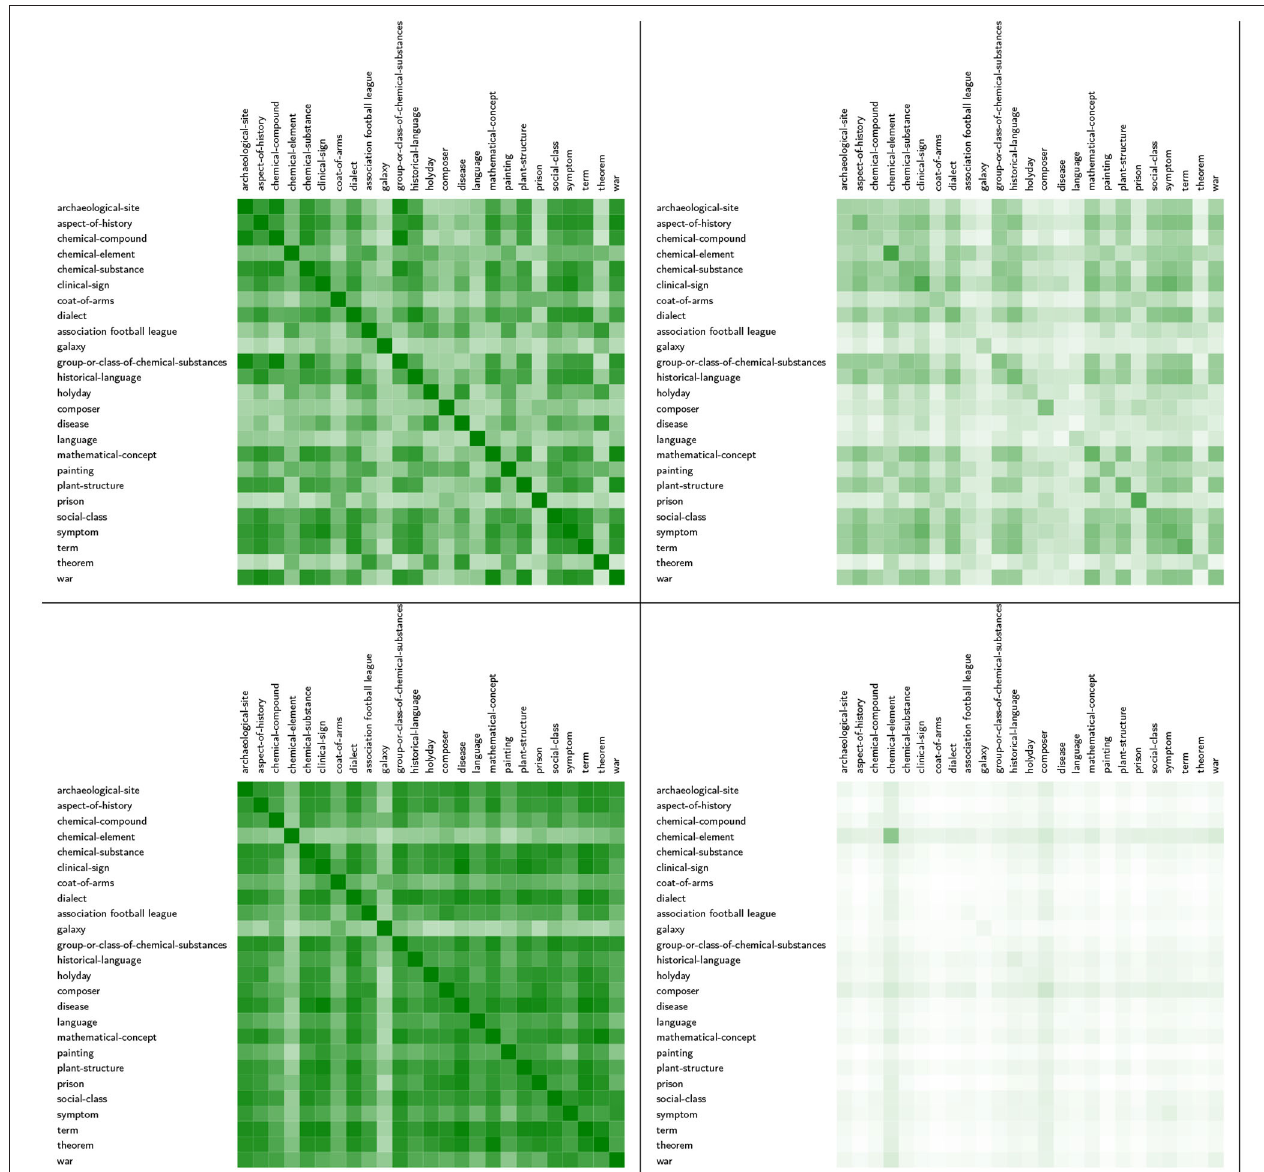
FIGURE 12 | From left to right: Unweighted and weighted distance correlations of the centralities of 35 languages in 25 language networks. First row: DeltaCon; second row: